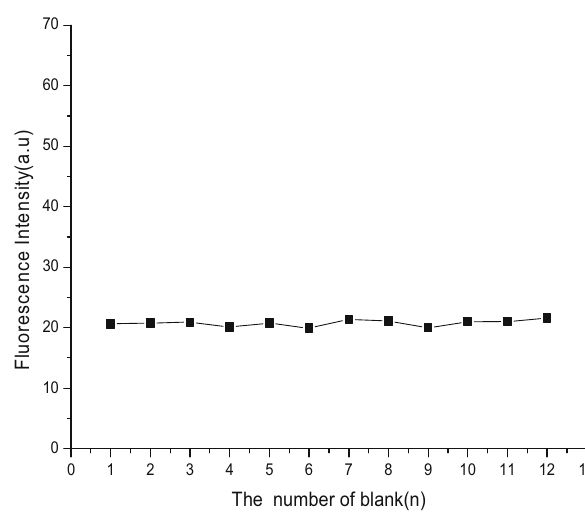
Figure 8: Spectral detection limit of blank sample ( n = 11 ) .